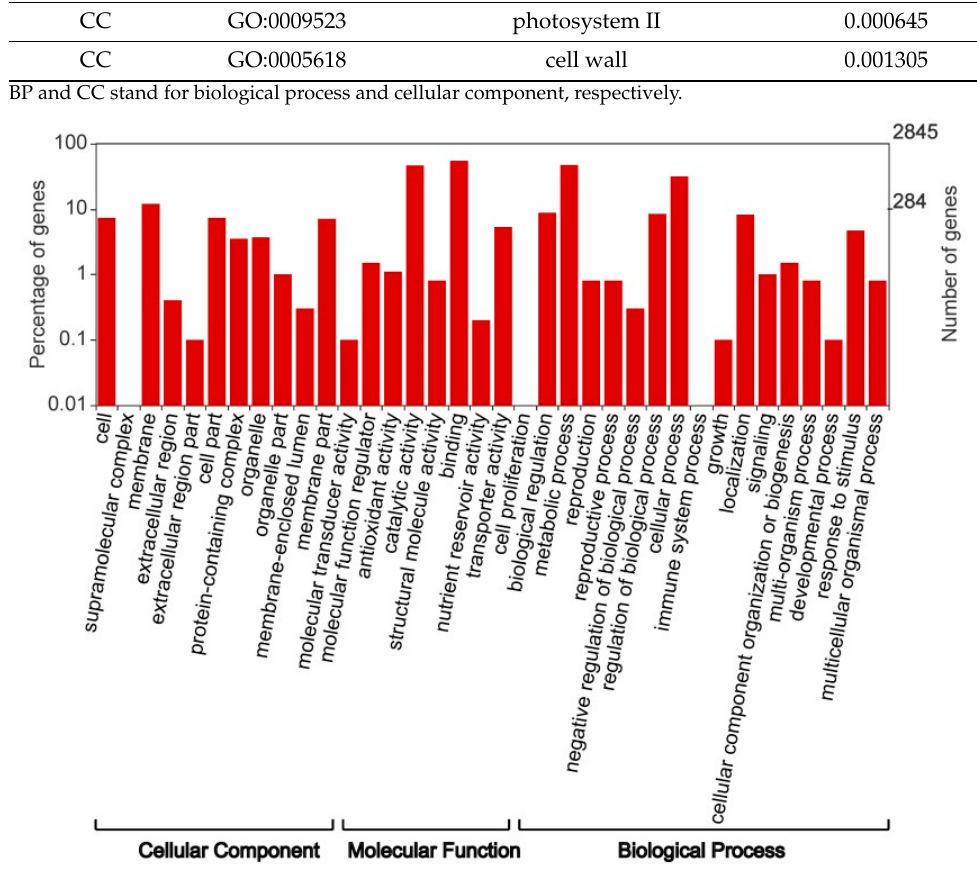
Table 4. Top ten signi fi cant GO terms of DG HP .